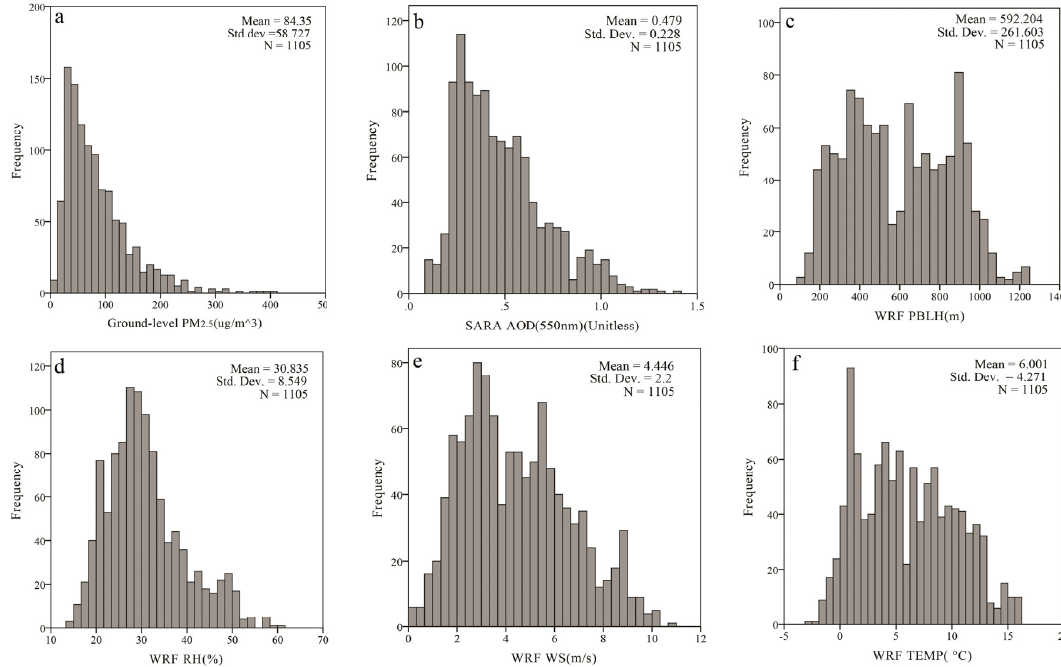
Figure 2. Histograms and descriptive statistics of six variables (( a ) Ground-level PM 2.5 ; ( b ) SARA AOD; ( c ) WRF PBLH; ( d ) WRF RH; ( e ) WRF WS; and ( f ) WRF TEMP).